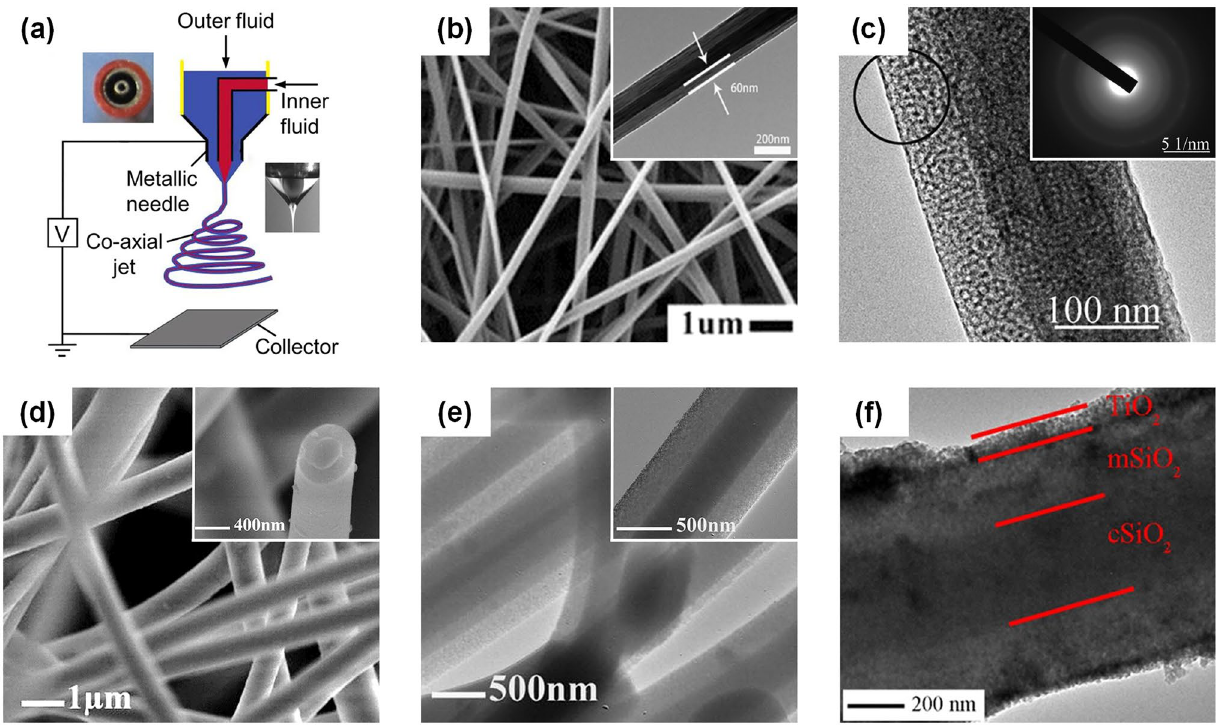
Fig. 3 a Schematic illustration of coaxial electrospinning device [64]. Copyright 2019, American Chemical Society. b SEM photograph of the as‑spun TiO 2 /SiO 2 nanofibers before calcination. The inset is the corresponding transmission electron microscope (TEM) photograph [81]. Cop‑ yright 2013, Elsevier. c High‑resolution TEM photograph of the SiO 2 /Al 2 O 3 nanofibers after calcination. The inset is the selected area electron diffraction pattern of the part denoted by the circle [82]. Copyright 2014, The Royal Society of Chemistry. d SEM image of the SNFs. The inset is the high‑magnified SEM image of the corresponding single nanofiber cross section [88]. e TEM image of the SNFs. The inset is the magnified TEM image of the corresponding single nanofiber [88]. Copyright 2011, Elsevier. f TEM image of the SiO 2 @TiO 2 nanofibers [89]. Copyright 2014, The American Ceramic